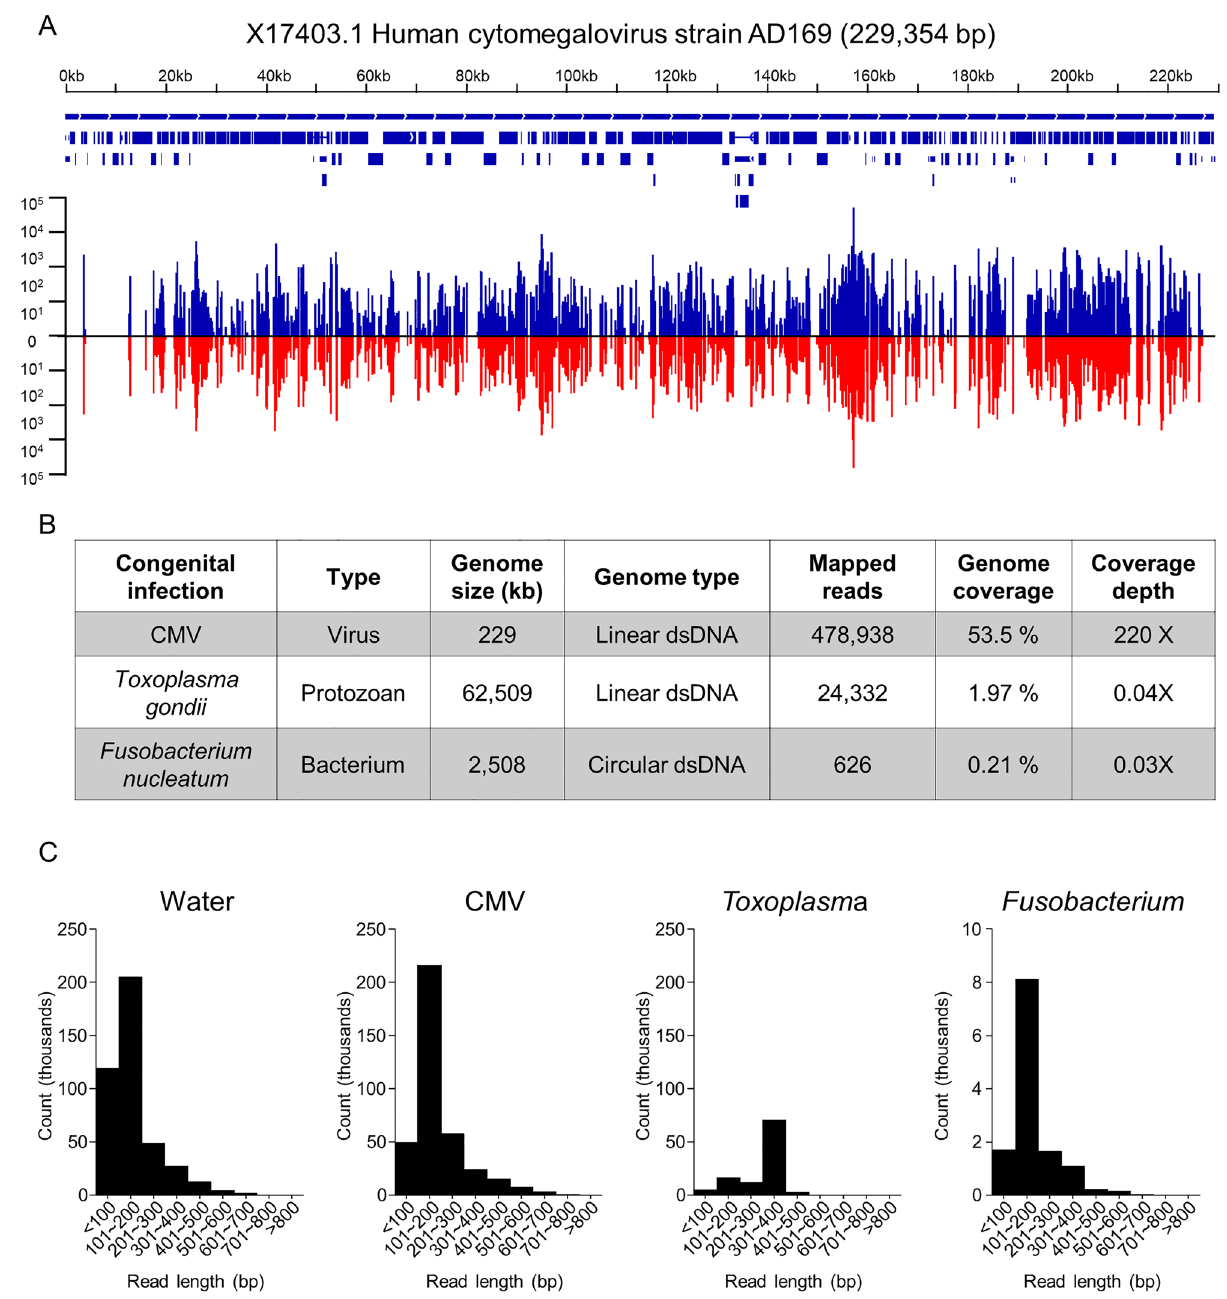
Figure 2. Detection of known infections. ( A ) Genomic graph illustrating the coverage and depth of CMV in the CMV-positive amniotic fluid sample (against reference CMV genome NC_006273.2). Top: gene location and genomic feature annotations from RefSeq. Bottom: number of reads mapped to genome. Blue lines above and red lines below the horizontal line indicate forward and reverse reads, respectively. The graph is generated using Bedfile and genomic snapshots from IGV. ( B ) Table showing genome coverage statistics for CMV, F. nucleatum , and T. gondii . ( C ) Histograms showing insert lengths (specifically, mapped paired end read separation distance) in water (left), CMV infection (middle left) and F. nucleatum infection (middle right) and T. gondii infection